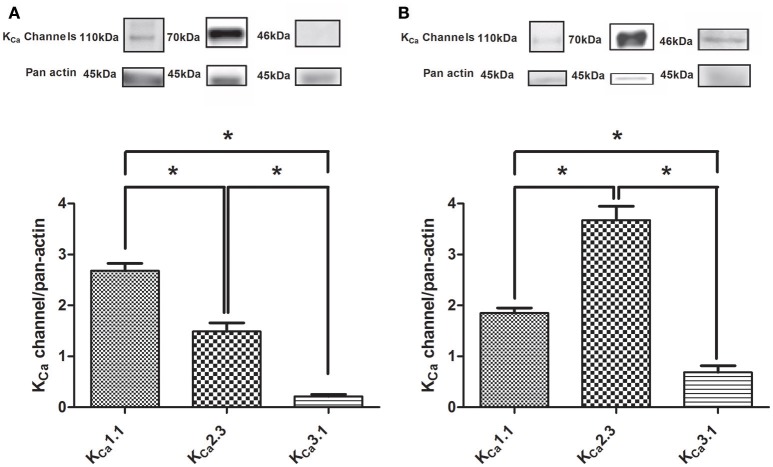
Immunoblotting of calcium-activated potassium channels in rat corpus cavernosum and the heart. (A) Immunoblotting of the KCa1.1 alpha subunit (n = 11), KCa2.3 (n = 14), and KCa3.1 (n = 12) channels in corpus cavernosum. (B) Immunoblotting of the KCa1.1 alpha subunit (n = 6), KCa2.3 (n = 5), and KCa3.1 (n = 3) channels in the heart. The results were expressed as a ratio to pan actin and show expression of mainly KCa1.1 and KCa2.3 immunoreaction in the corpus cavernosum. Data are expressed as means ± S.E.M. *P ≤ 0.05, one-way ANOVA followed by Student's t-test.